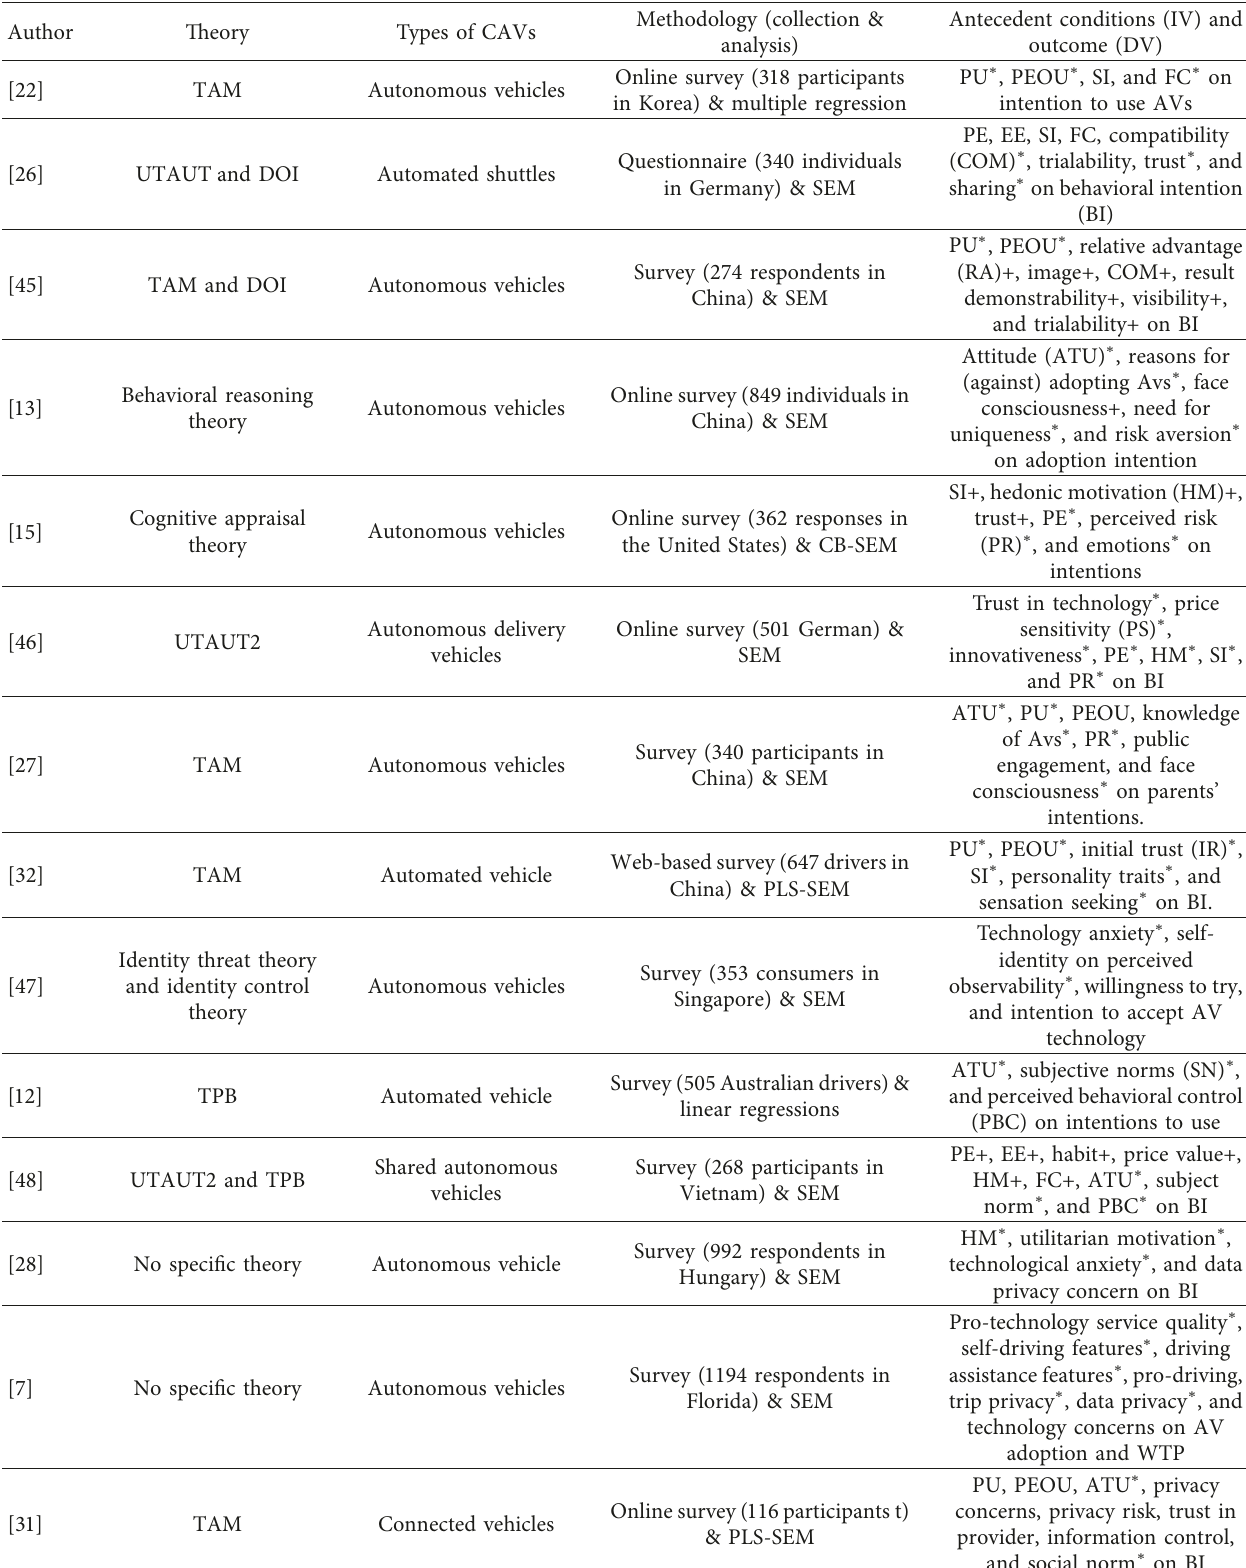
Table 1: Empirical studies on CAVs